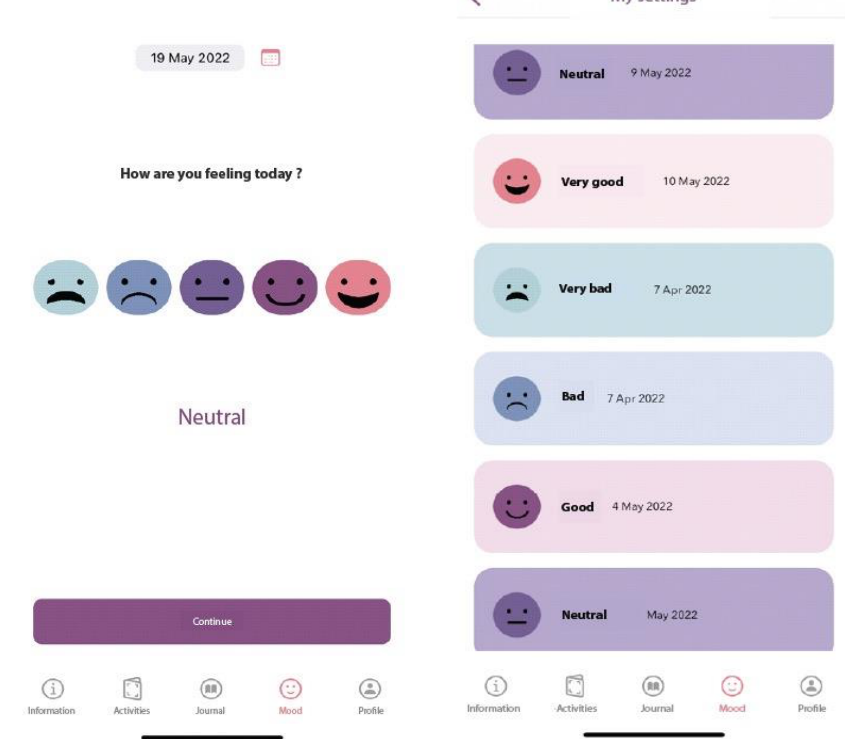
Figure 6. Mood Monitoring in the ADHD Coping Card app.